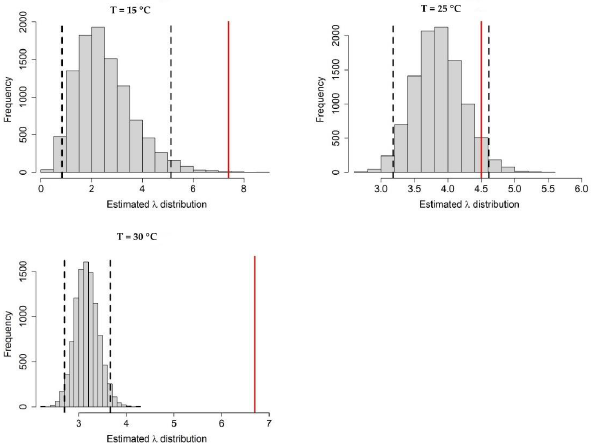
Figure A1. Estimated posterior distributions of Λ E (T), the average length of time (days) between immersion of eggs in water and hatching response at 15, 25, and 30 °C. Dashed black lines represent the 2.5 and 97.5 quantiles. Solid red lines represent the average value for subtropical Ae. albopictus .